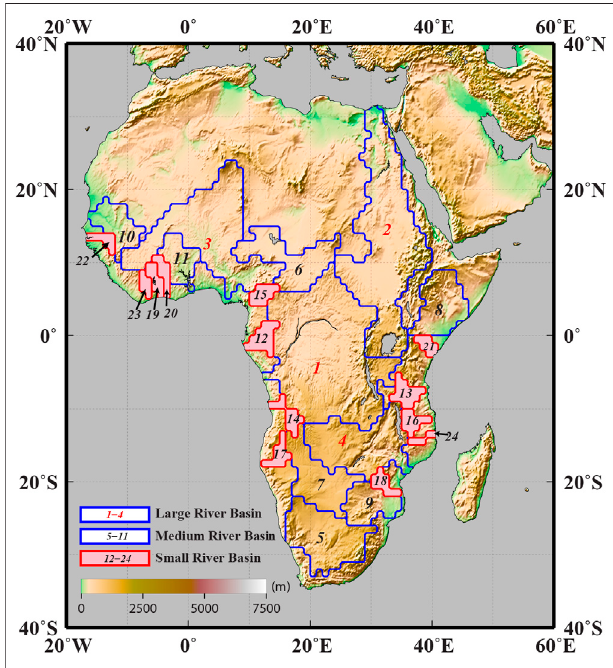
FIGURE 1 | The study region of Africa. According to the size of river basins,theyarecategorizedaslargeriverbasin,mediumriverbasin,andsmall river basin. More details of these river basins are listed in Table 1